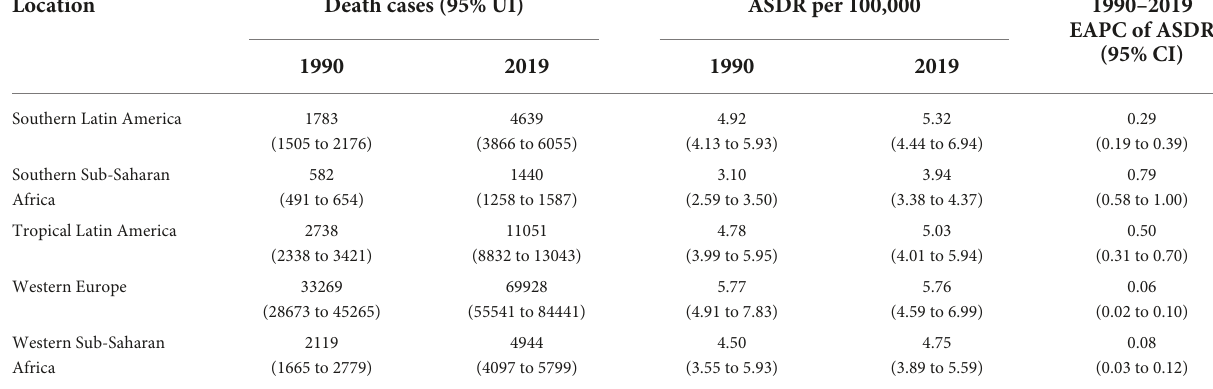
( Table 3 ). The highest number of DALYs was detected in China, India, and the United States of America, whereas the Montenegro, Greenland, and Sweden were the three countries with the highest age-standardized DALY rate ( Supplementary Figures 1, 2 and Supplementary Table 1 ). The EAPC of